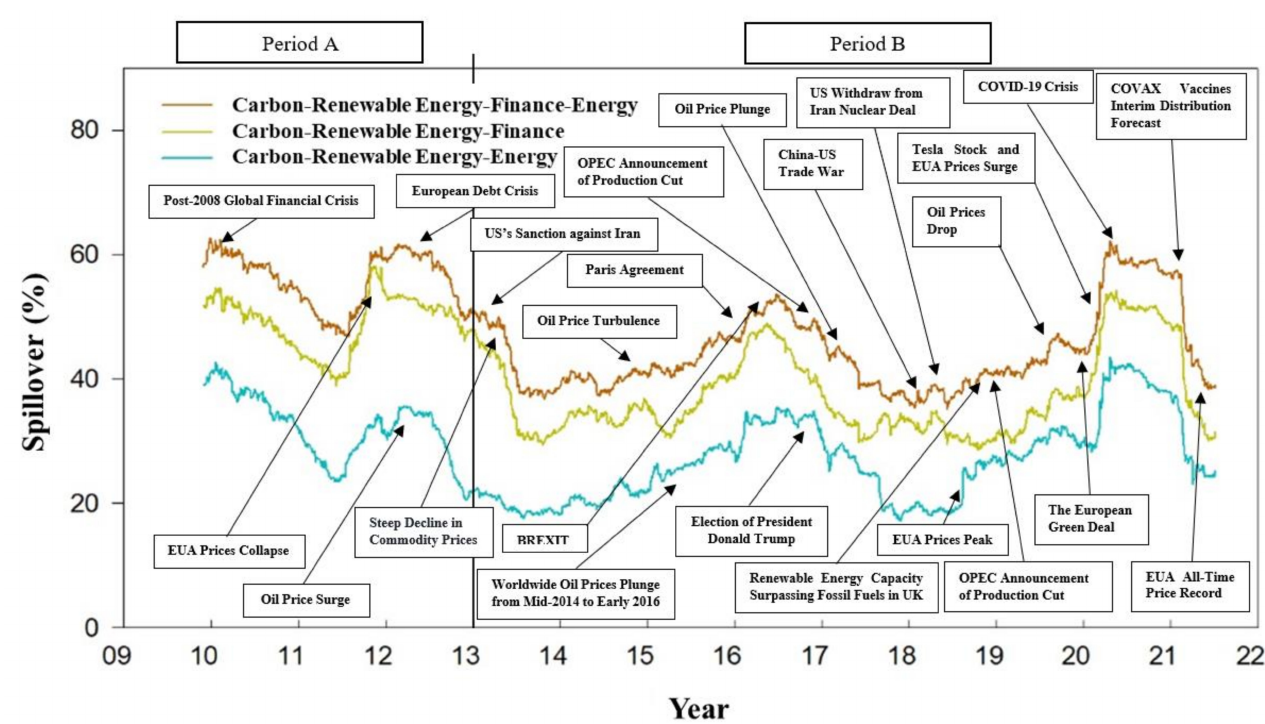
Figure 1. Spillover Plot of Total Return Spillovers Indexes of “Carbon-Renewable Energy-Finance-Energy”, “Carbon- Renewable Energy-Finance” and “Carbon-Renewable Energy-Energy” Market Systems. Note: We plot the time series of the total return spillover indexes of the “Carbon-Renewable Energy-Finance-Energy”, “Carbon-Renewable Energy-Finance” and “Carbon-Renewable Energy-Energy” market systems based on 252-day rolling samples for the period from 1 December 2009 to 8 July 2021. The underlying variance decompositions are based on VAR models with lag orders of 7, 7 and 6, as suggested by the AIC. The forecast horizons are all 5 days. In the plot, we mark the major market and political events during the studied